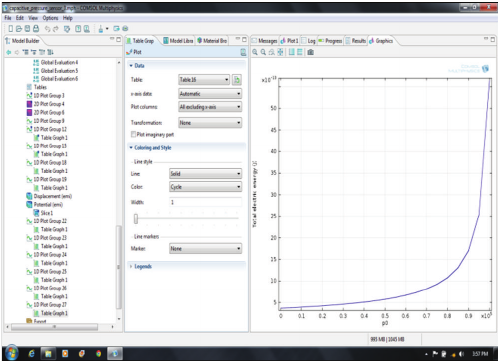
Figure 16: Plot of total electric energy versus pressure in MEMS capacitive pressure sensor.